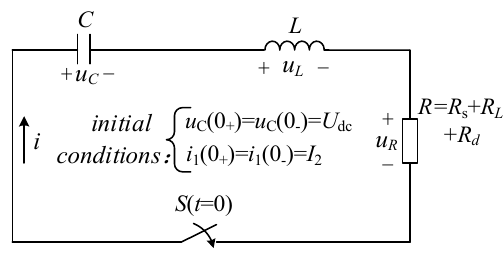
Figure 6. Equivalent discharge circuit of DC transformer.